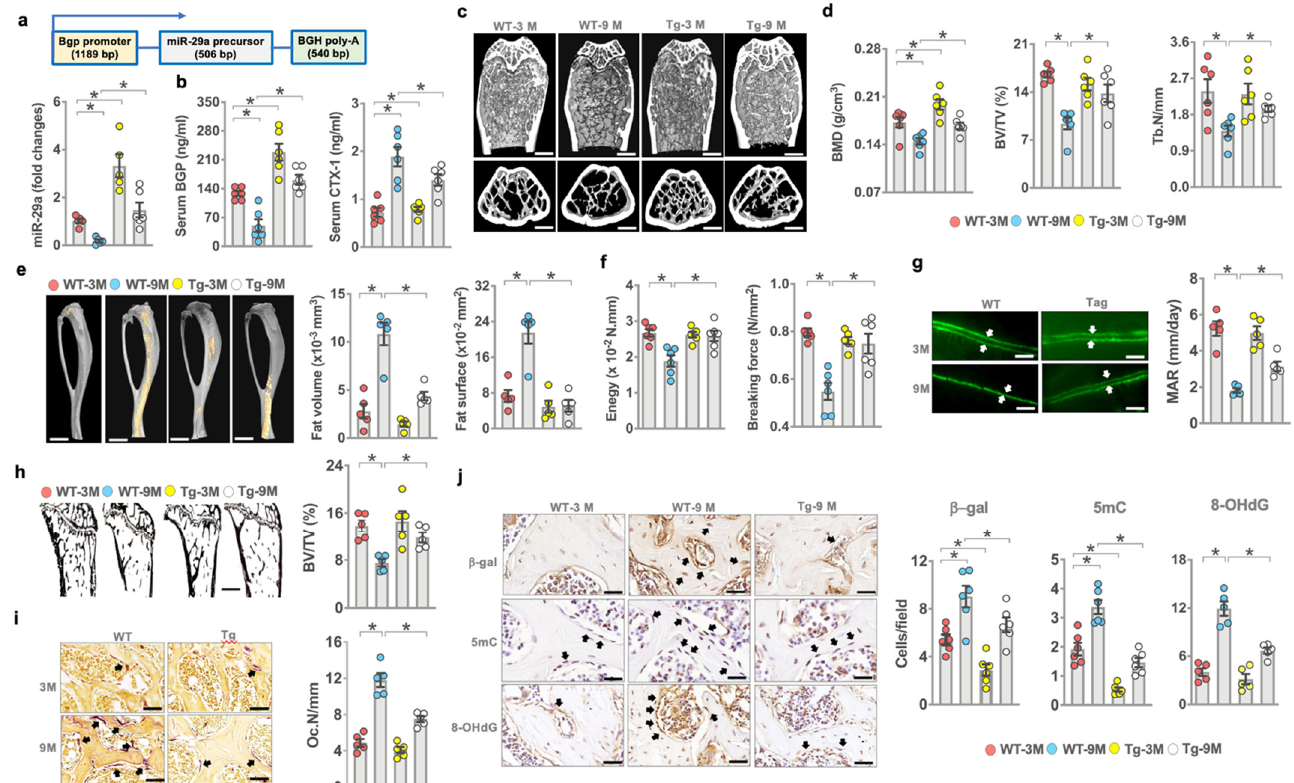
Figure 3. Effects of miR-29a overexpression on bone mass, mechanics, and histomorphometry of young and aged mice. Schematic drawing for the linear gene construct for the generation of osteoblast-specific miR-29aTg mice. miR-29a overexpression attenuated miR-29a loss in bone tissue ( a ) and serum Bgp and CTX-1 level alteration in old mice ( b ). μ CT revealing sparse trabecular microstructure in old WT mice and well-woven bone architecture in old miR-29aTg mice ( c ); scale bar, 50 μ m in upper panels; 90 μ m in lower panels. miR-29a overexpression improved age-induced loss in BMD, BV/TV, and Tb.N ( d ). miR-29a compromised fatty marrow development (scale bar, 5 mm) ( e ) and biomechanics loss ( f ) and reversed mineral acquisition (scale bar, 40 μ m) ( g ) and von-Koss-stained trabecular bone volume (scale bar, 40 μ m) ( h ), as well as reduced TRAP-stained osteoclast formation (scale bar, 20 μ m) ( i ). miR-29a overexpression attenuated β -galactosidase, 5mC, and 8-OHdG immunoreactivity ( j ); scale bar, 15 μ m. The significant difference (asterisks *) of investigations (mean ± standard error, n = 5–6 mice) was analyzed using an ANOVA test and Bonferroni post hoc test.